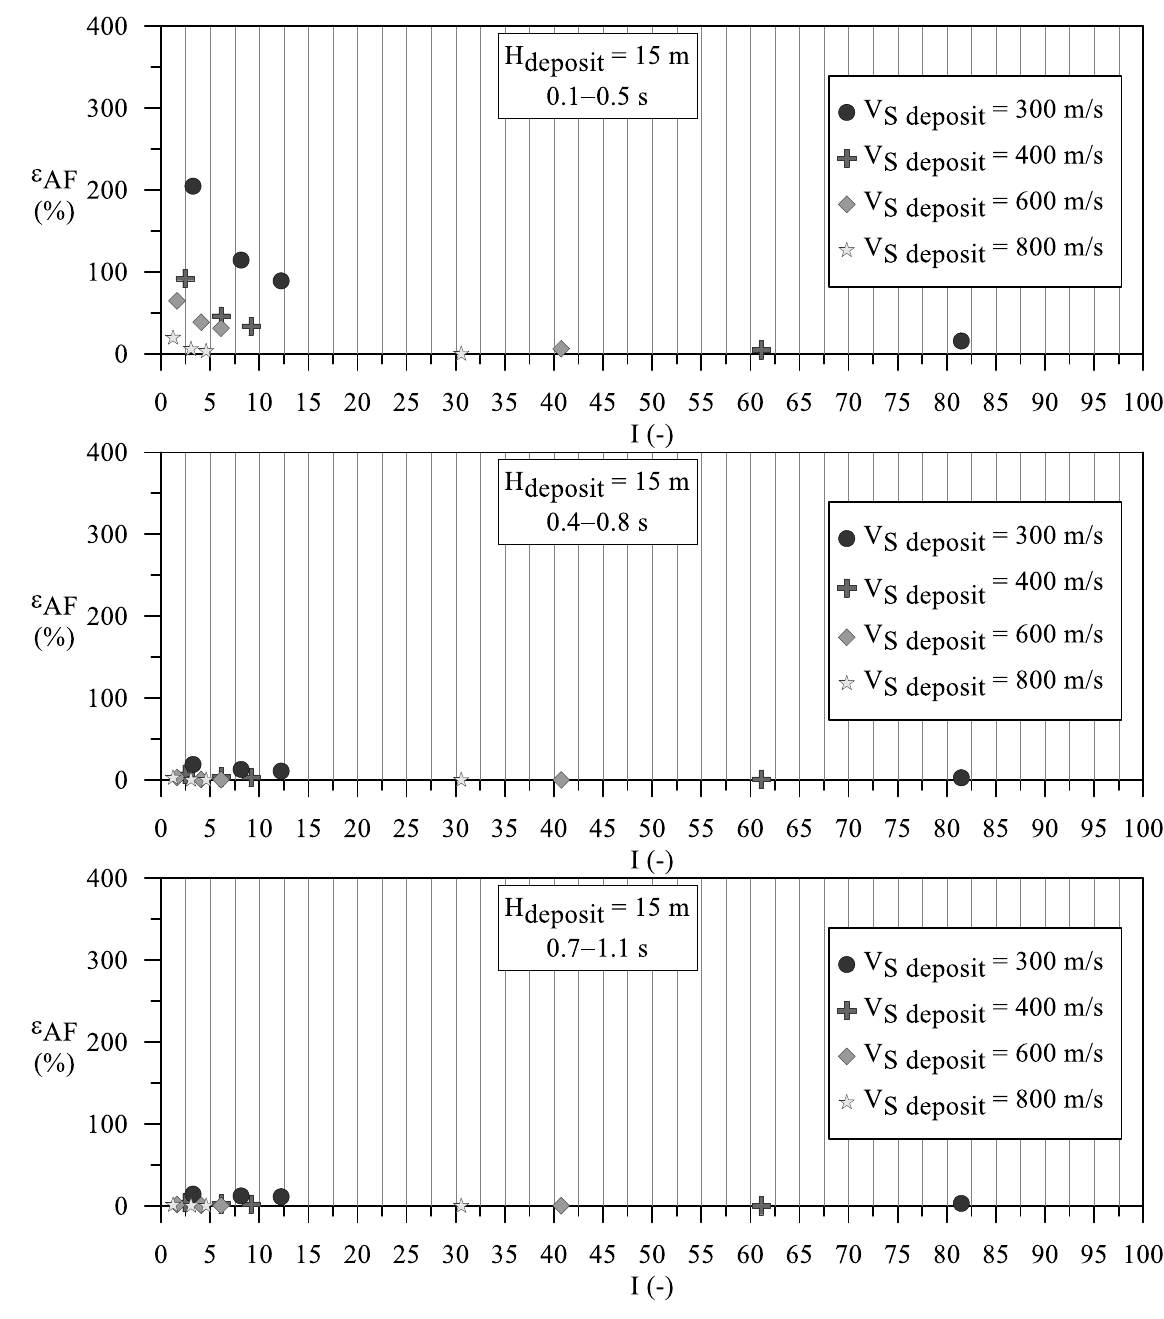
Figure 4. Error in the estimation of AFs quantified according to the Equation (2), with reference to cover deposit thickness equal to 15 m and linear visco-elastic materials. In detail, assuming V S = 20,000 m/s for the half-space, the impedance contrast results equal to 81.5, 61.1, 40.7, and 30.6 with reference to the deposit V S equal to 300, 400, 600, and 800 m/s, respectively.